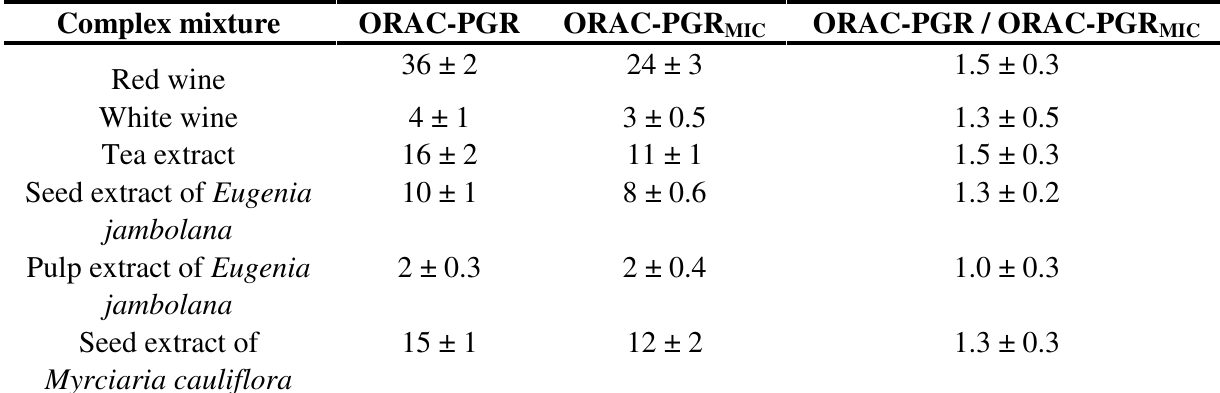
values of complex mixtures a MIC